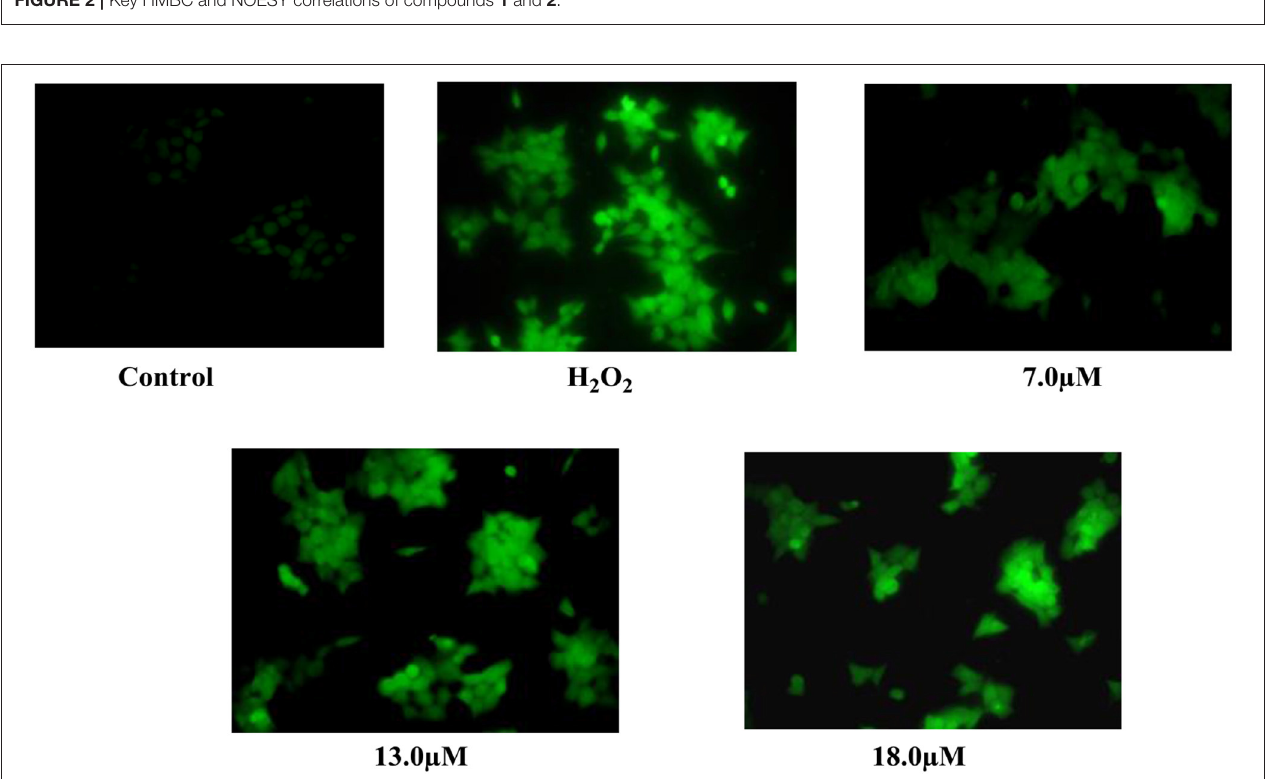
FIGURE 3 | Effect of coronarin K (1) on cellular and nuclear morphology of A-549 in ROS production assessed from the oxidation of DCFDA by H 2 O 2 through fluorescence microscopy at 48-h posttreatment.